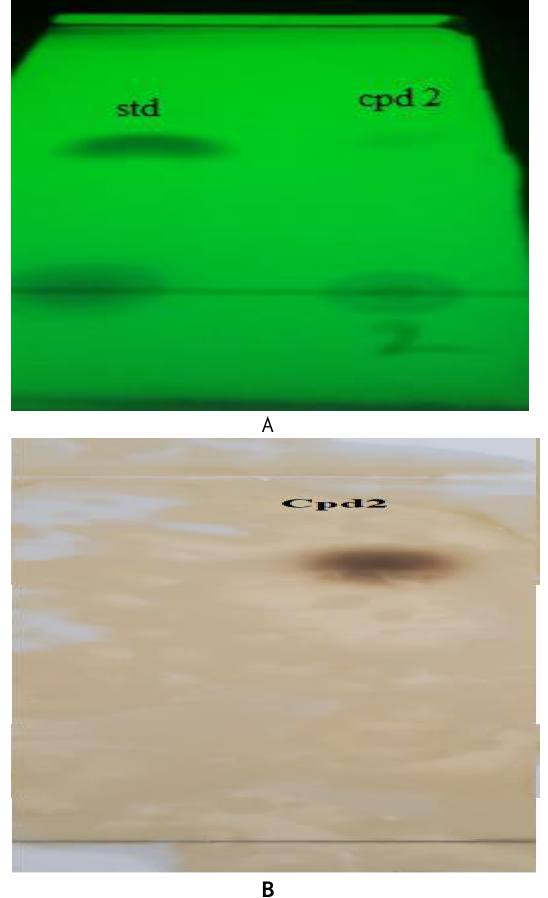
Figurei8. TLC chromatography(A) for isolated compound number (2) from ethyl acetate fraction and Sinapic acid standard using silica gel Gf254 as adsorbant and mobile phase S1 (B) separated compound after detected by spraying with five %ferric chlorides.